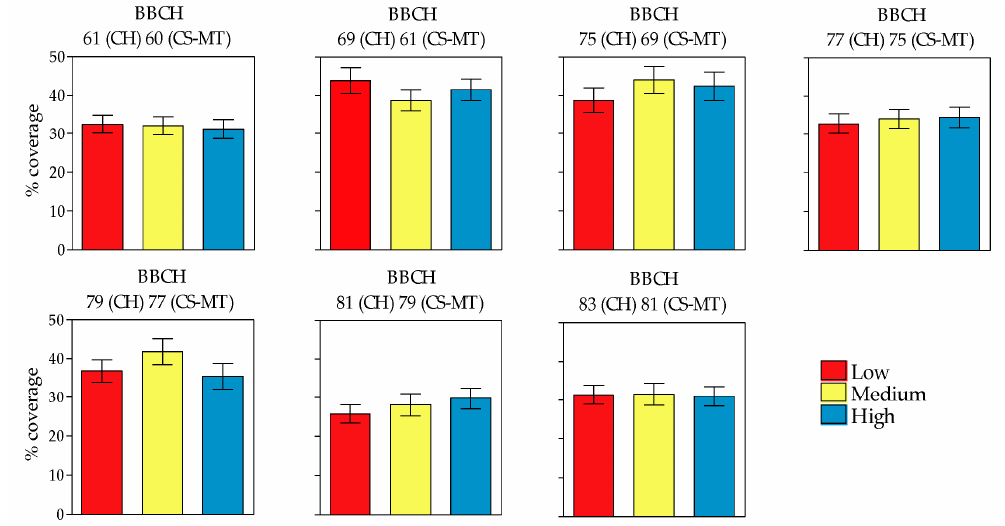
Figure 9. Percentage of water sensitive papers coverage obtained each vigor. Mean of the parcels ± SEM.